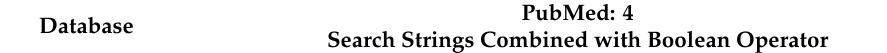
Table 1. Electronic search strategy for